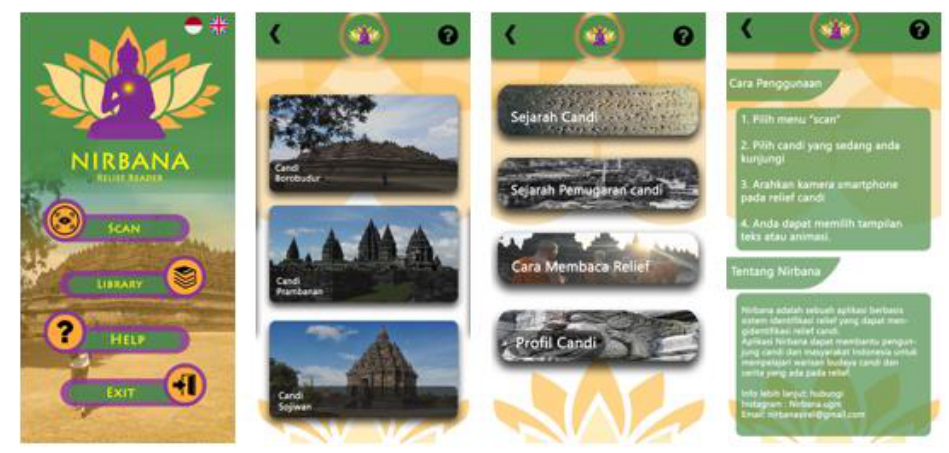
Fig. 5 Nirbana Program